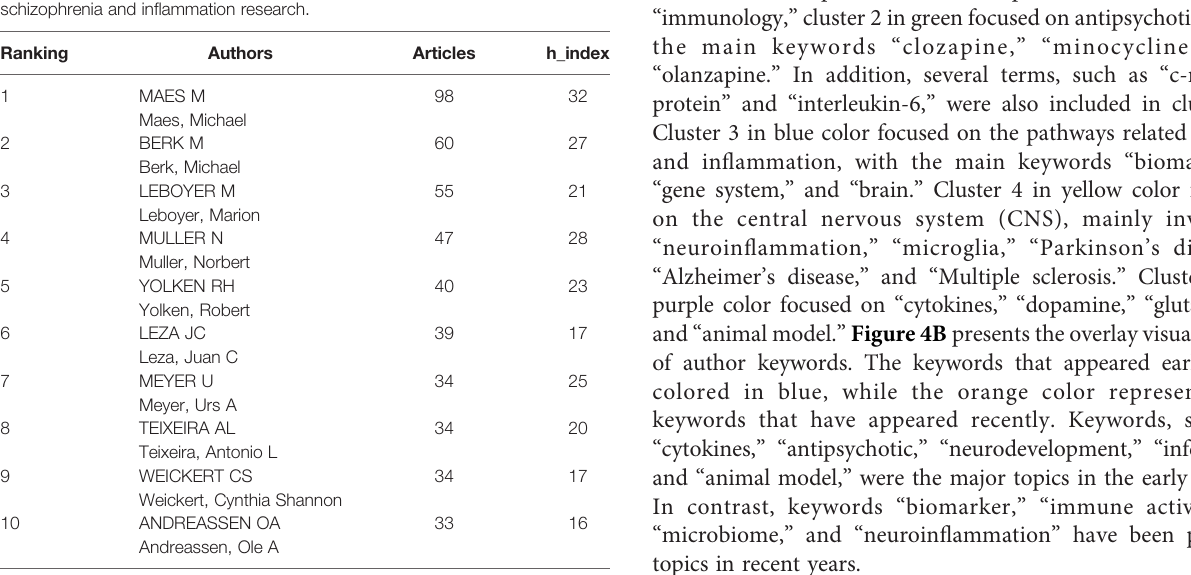
occurrence frequency of keywords, while the distance between two nodes re fl ects the strength of their association. Keywords with a closer distance were classi fi ed into the same cluster, which roughly re fl ects the main topics in the SCZ and in fl ammation research area. Cluster 1 is colored in red, with the main keywords focusing on psychiatric disorder- and in fl ammation-related